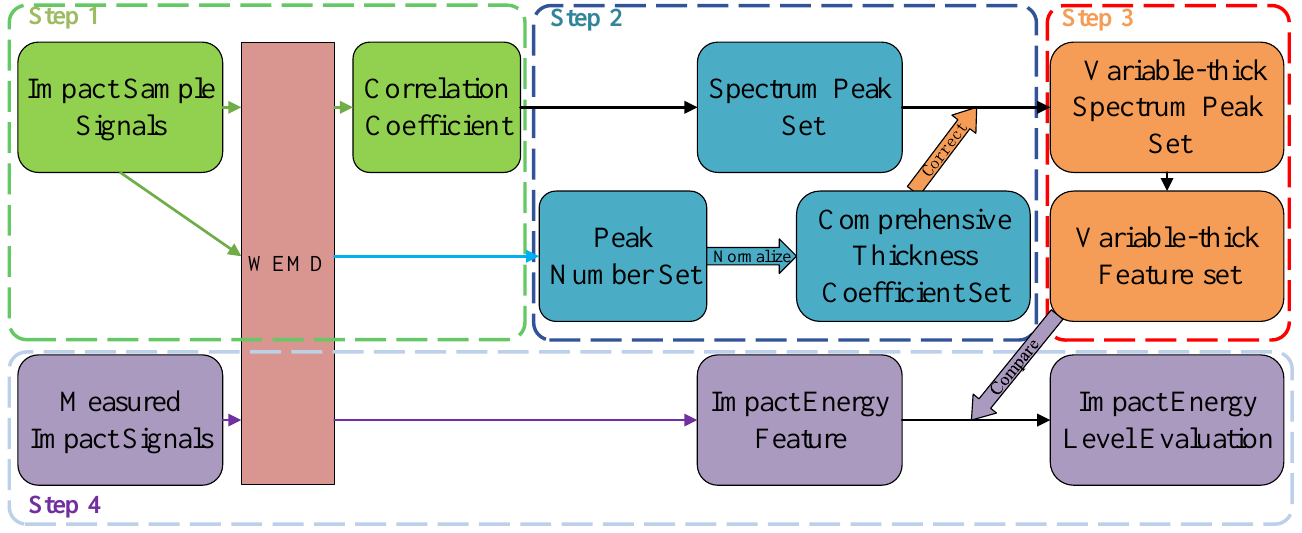
Figure 1. Low velocity impact energy recognition flow chart of variable thickness composite